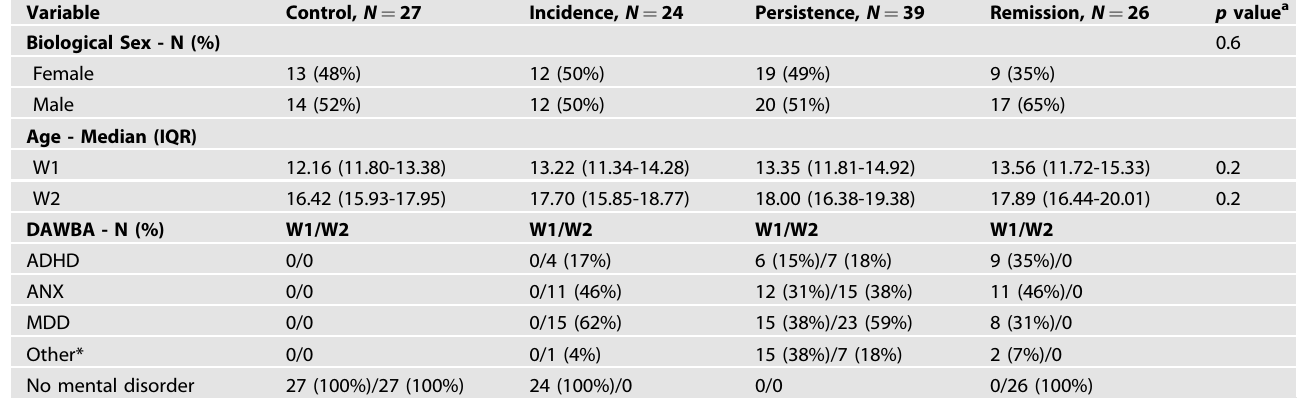
Table 1. Descriptive statistics of the study.